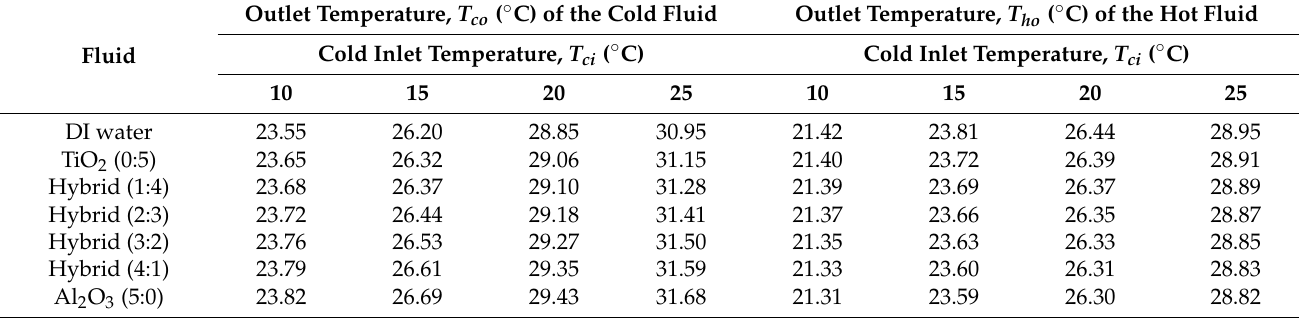
Table 8. Recorded cold and hot fluids outlet temperature keeping the hot inlet temperature ( T hi ) at 35 ◦ C and varying the cold inlet temperature ( T ci )